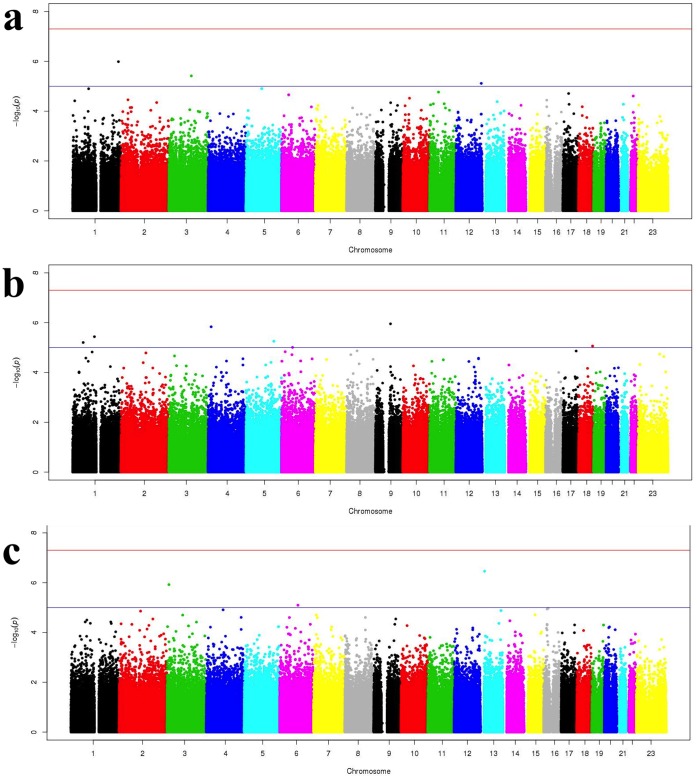
Manhattan plots of –log(P) for association of SNPs and chromosomal position for all SNPs analyzed in linear regression covariate-adjusted models.Panel A presents the Manhattan plot for the phenotype, ADHD-IV Impulsivity Scale. Panel B presents the Manhattan plot for the phenotype, CBCL/1.5-5 PDPs. Panel C presents the Manhattan plot for the phenotype, CBCL/1.5-5 Total Problems. Red horizontal line represents 5×10−8 threshold for genome-wide significance. Blue horizontal line indicates the 10−6 threshold for suggestive genome-wide significance.